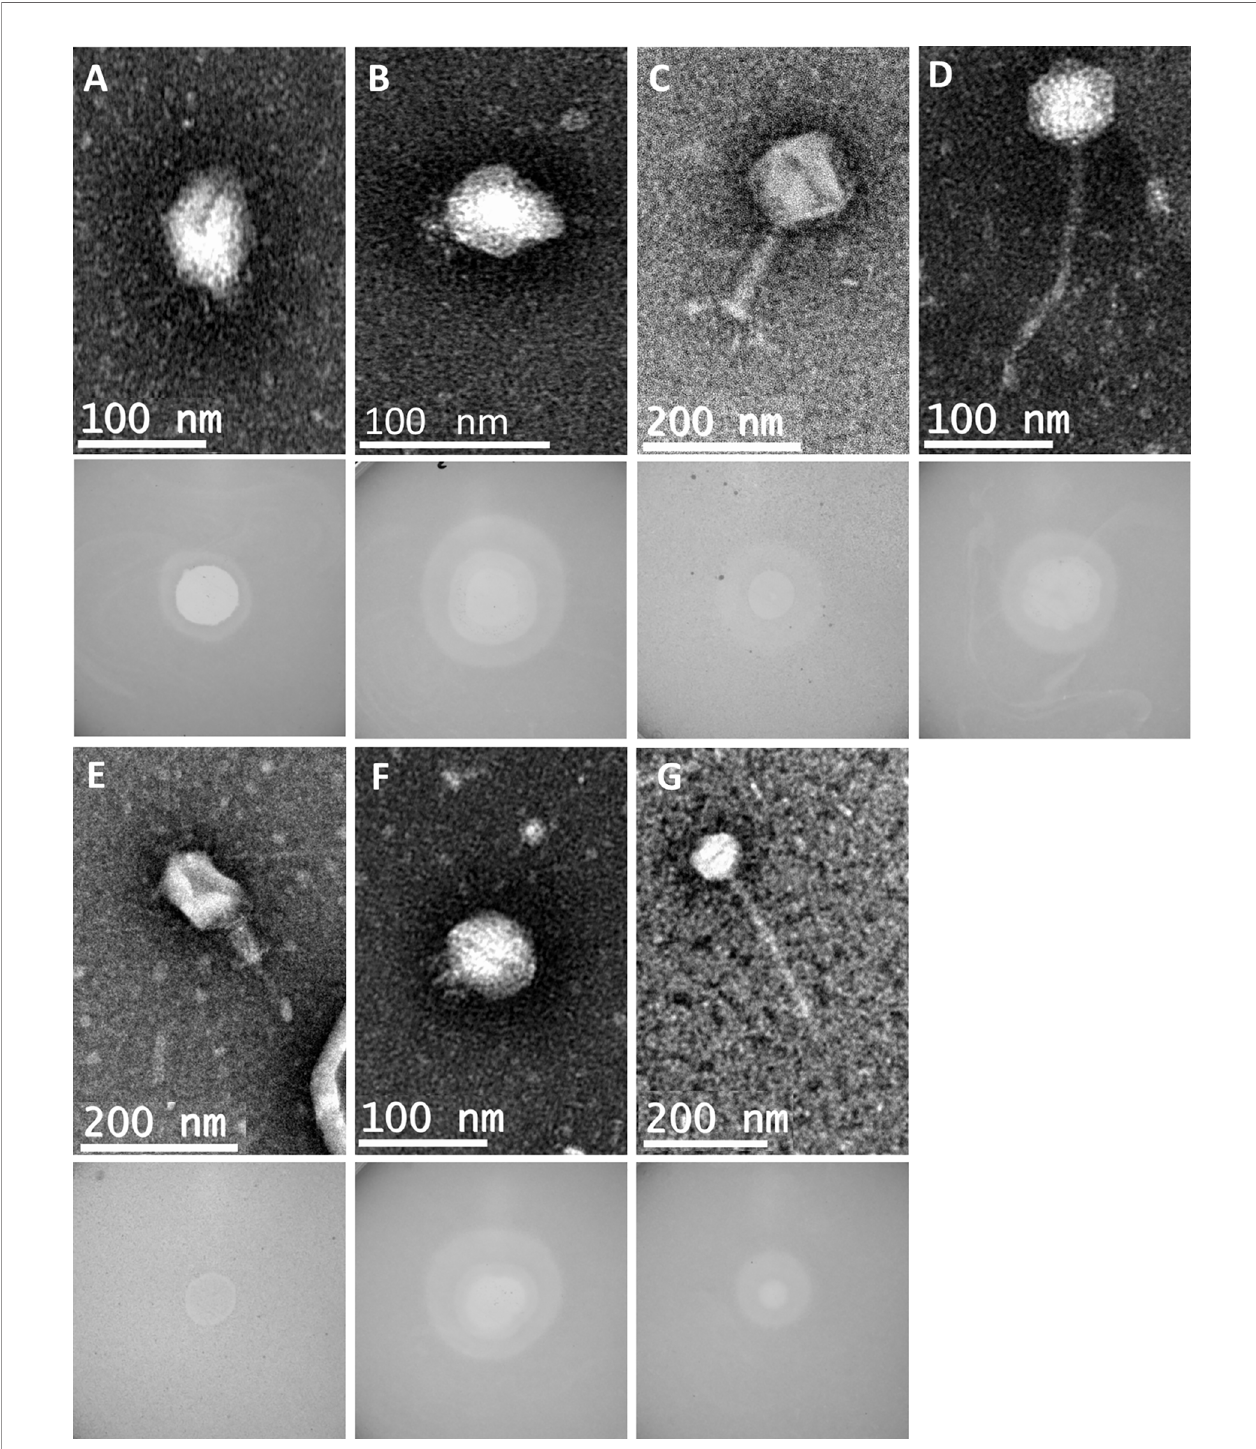
FIGURE 2 | Representative transmission electron micrographs and plaque morphology of the seven exemplars for each of the genetically distinct phage groups de fi ned in this study and shown in Table 2 . (A) GBH001 (mean capsid diameter 63.4 nm; mean tail length N/A; n = 10) (B) GBH014 (64.0 nm; N/A; n = 7) (C) GBH019 (132.7 nm; 163.4 nm; n = 9) (D) GBH029 (73.8 nm; 188.8 nm; n = 7) (E) GBH033 (86.7 nm; 105.2 nm; n = 8) (F) GBH038 (72.0 nm; N/A; n = 6) (G) GBH054 (81.2 nm; 256.4 nm; n =